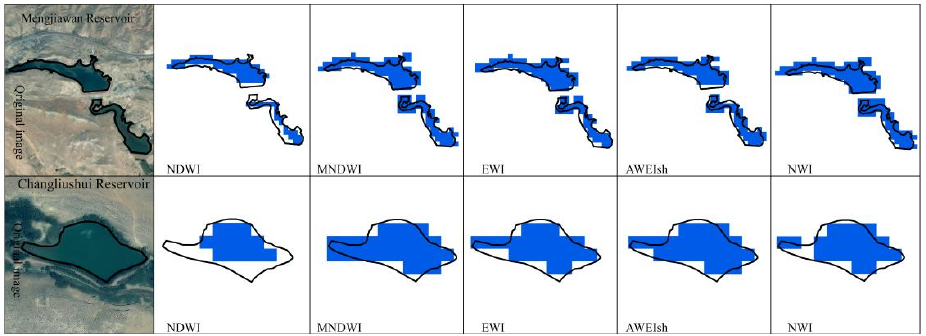
Figure 8. Extraction effect of reservoir boundary.